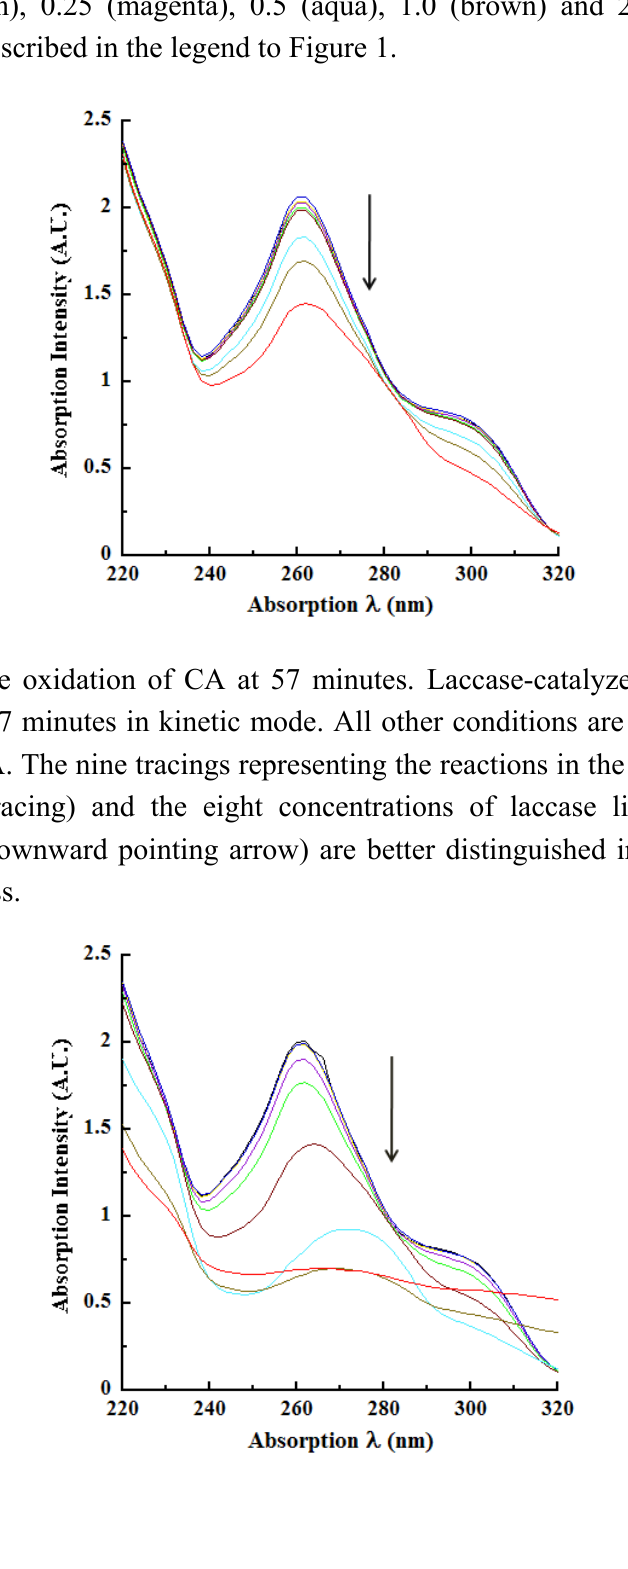
Figure 3A. Laccase oxidation of CA at 13 minutes. Increasing concentrations of T. versicolor laccase was reacted with 500 μ M CA for 13 minutes at pH 4.5 in real time kinetic mode. The changes in absorption intensities consequent to enzyme catalysis were monitored by scanning between 220 to 320 nm in 2 nm intervals. The various tracings with progressively decreasing absorption intensities, indicated by the downward pointing arrow, represented reactions in the absence of laccase (0 μ g/mL; black tracing) as well as increasing concentrations ( μ g/mL) of laccase as follows: 0.01 (yellow), 0.025 (blue), 0.05 (purple), 0.1 (green), 0.25 (magenta), 0.5 (aqua), 1.0 (brown) and 2.0 (red). All other